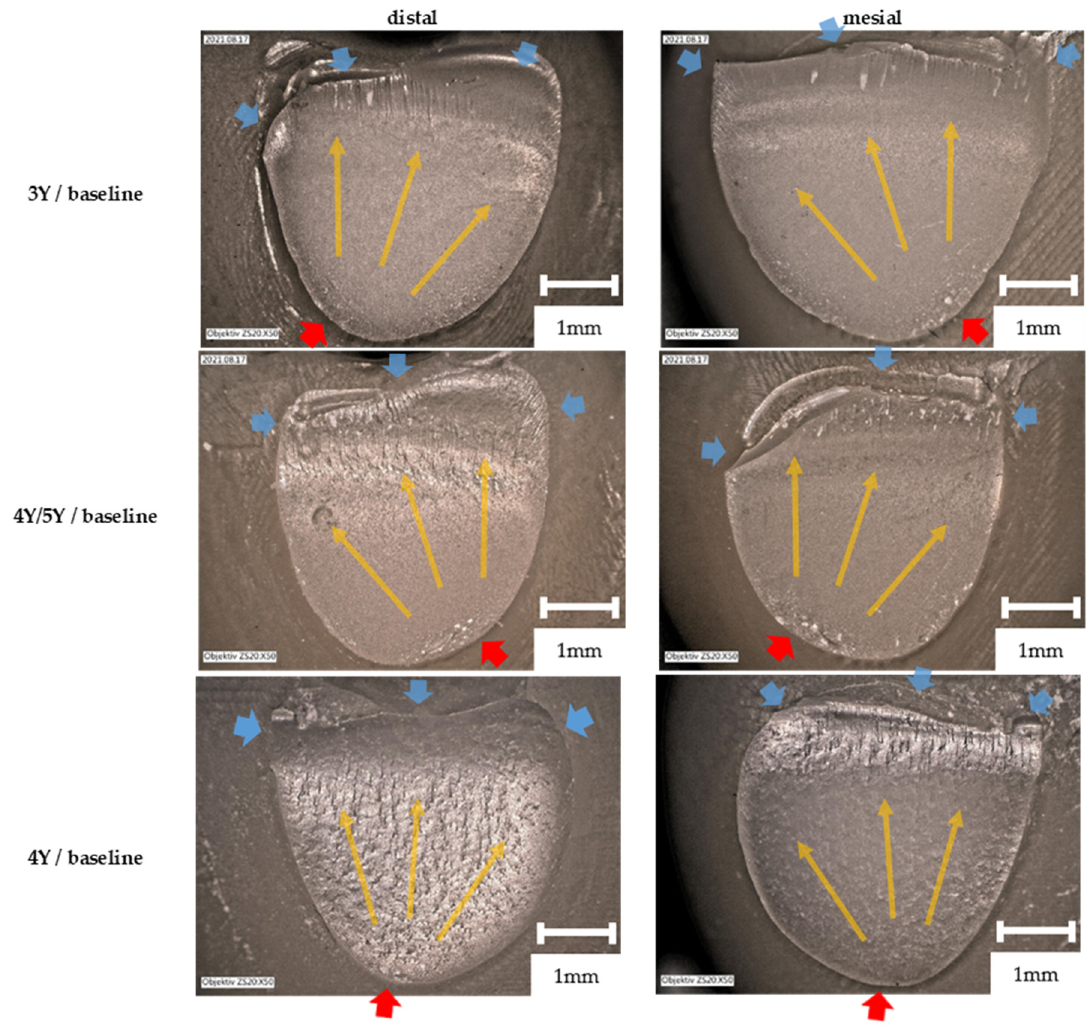
Figure 2. Exemplary fracture surfaces (mesial/distal aspect; cross section approx. 12 mm 2 ; EOS 60D with macro lens EF-S 60mm 1:2.8 and macro ring lite MR-14EX, Canon, Ō ta, J): crack initiation at defects in the connector area on the gingival side of the restoration (red arrows), crack propagation to the top (yellow arrows) and to the sides of the connector, occlusal fracture edge (blue arrows).